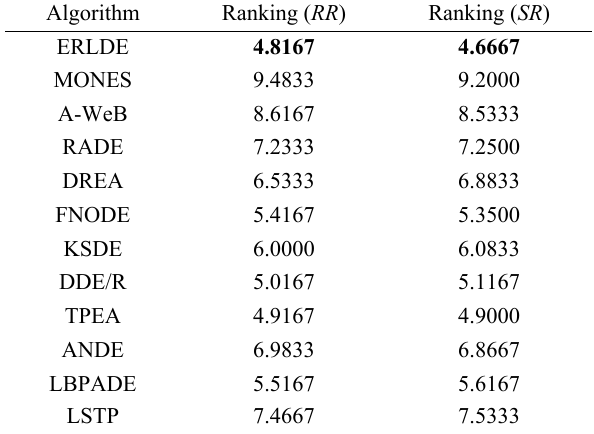
Table 5 Wilcoxon test results obtained according to the RR and SR of different algorithms.